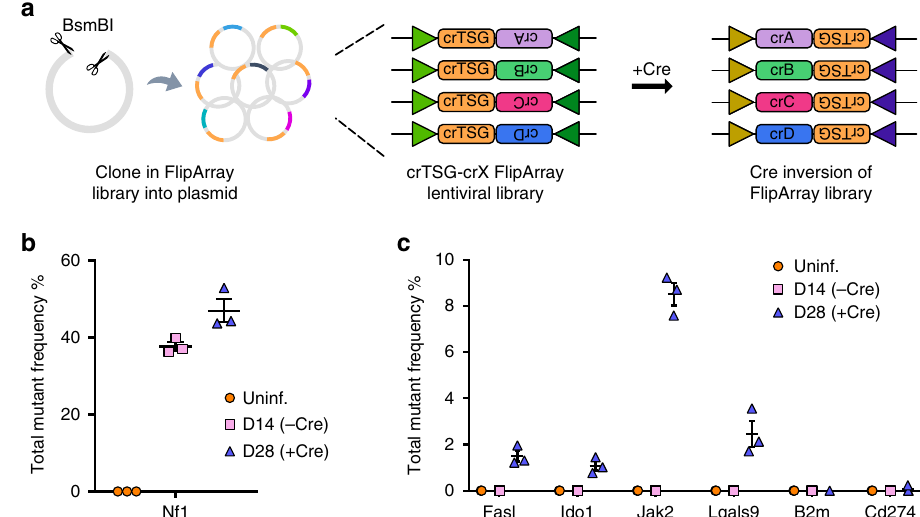
Fig. 4 Pooled sequential mutagenesis to model acquired resistance to immunotherapy. a Schematic of the experimental approach for pooled sequential mutagenesis using Cpf1-Flip. Following restriction digest, a library of FlipArrays is cloned into the base vector. In each FlipArray, the fi rst crRNA targets a tumor suppressor ( Nf1 ), while the second crRNA targets a panel of putative immunomodulatory factors. Cre-mediated inversion induces expression of the second crRNA. b Dot plot detailing the total variant frequencies at the crNf1 target site in uninfected cells, 14 days after FlipArray transduction ( − Cre), and 28 days after FlipArray transduction ( + Cre). c Dot plot detailing the total variant frequencies at the second crRNA target sites ( Fasl , Ido1 , Jak2 , Lgals9 , B2m , and Cd274 ) in uninfected cells, 14 days after FlipArray transduction ( − Cre), and 28 days after FlipArray transduction ( + Cre). All error bars are mean ± s.e. m ( n = 3 cell replicates for all